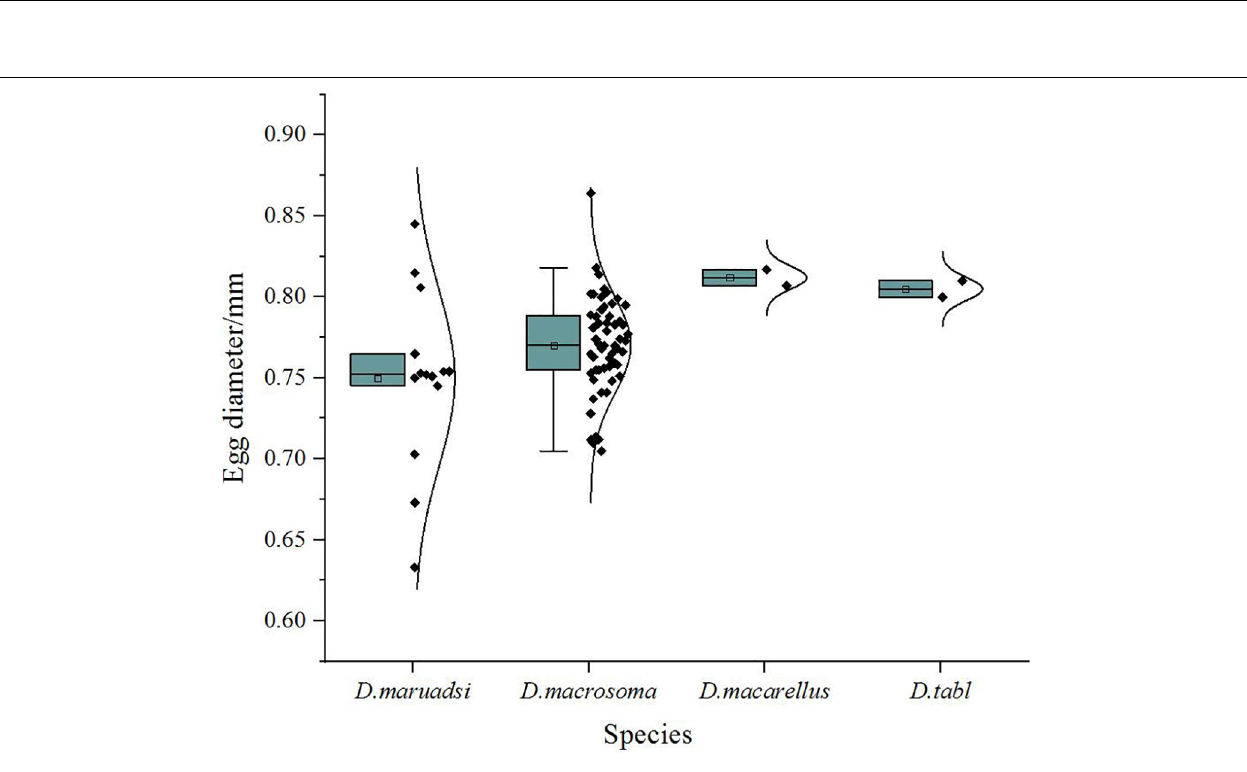
Frontiers in Marine Science |